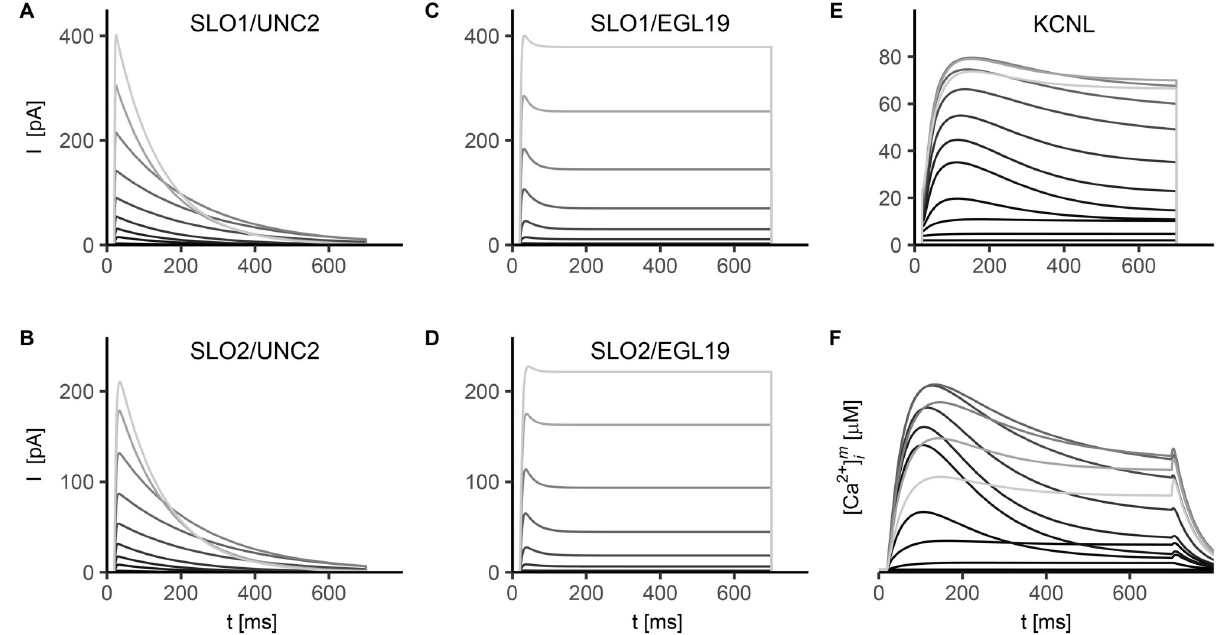
Fig 3. Simulated currents of calcium-regulated potassium channels SLO-1, SLO-2 and KCNL. Stimulation protocol consists in 10 mV voltage steps ranging from -80 mV to -40 mV. Each step lasts 600 ms, and is applied from a holding potential V h = − 80 mV. For both SLO1 and SLO2 we set the conductance to 15 nS (Eq 1). For KCNL current the conductance is � g ¼ 1 : 5 nS . The modified set of parameters, i.e. fine-tuned to match neuron KCNL data (see S1 Table), has been used for CaV channels dynamics. A-B) SLO1 (A) and SLO2 (B) coupled with UNC-2 Ca 2+ channels . SLO1 and SLO2 simulated currents show fast activation ( t � 8 ms , and t � 5 ms , Eq 22). Current activation is followed by inactivation shaped by the m SLO 1 m SLO 2 inactivation variable of the coupled UNC2 current (Eq 23). C-D) SLO1 (C) and SLO2 (D) coupled with EGL-19 Ca 2+ channels . Analogously to panels A-B the currents show fast activation, while partial inactivation is strictly related to the limited inactivation of EGL19 calcium current (Eq 23, Fig 2A and S3 Fig). E) KCNL current . Experimental data from [67, 68]. KCNL channels exhibit slow activation ( t ¼ 6 : 3 ms ) and inactivation. The m KCNL steady-state activation function depends only upon intracellular calcium concentration (Eq C6 in S1 File and S5 Fig). F) Simulated intracellular calcium concentration . ½ Ca 2 þ � m during voltage clamp simulation is calculated by solving Eq 28, where I Ca is given by I EGL19 + I UNC2 + I CCA1 with i � g ¼ � g ¼ � g ¼ 1 nS EGL 19 UNC 2 CCA 1